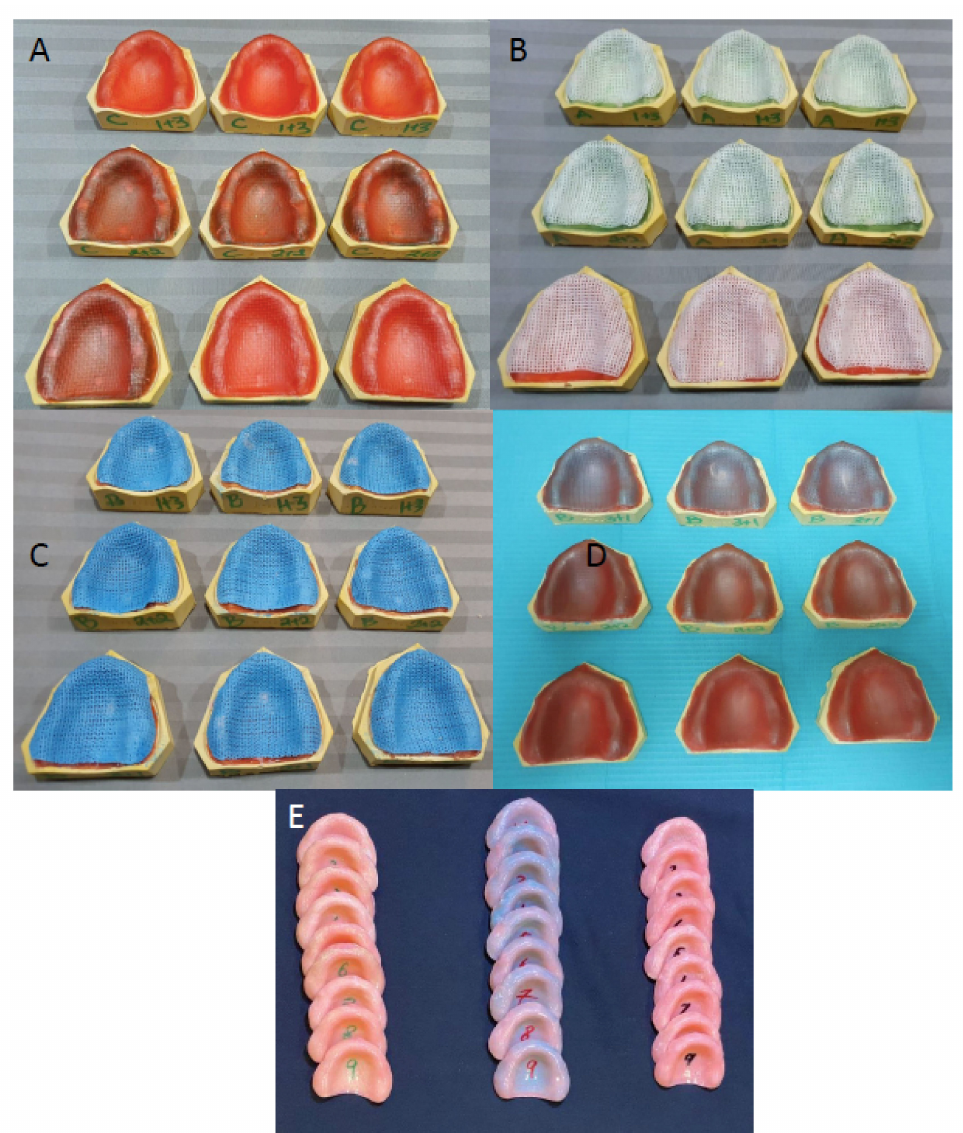
Figure 1. PMMA resin reinforcement mesh groups. Group 1. Dental fiberglass framework reinforce- ment ( A ). Group 2. Orthopedic casting tape, Delta Lite Plus reinforcement ( B ). Group 3. Orthopedic casting tape, Shanghai Nineluck reinforcement ( C ). Wax up of all reinforced groups ( D ). Processed dentures ( E